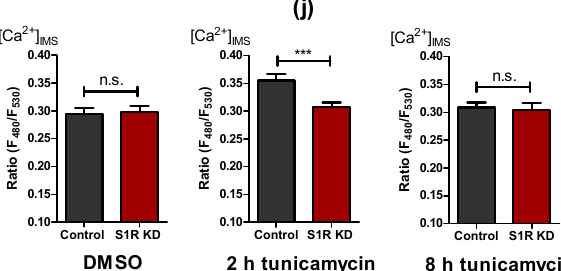
Figure 4. Cells develop an enhanced ER Ca 2+ leak that is directed towards mitochondria by S1R during early ER stress. Time course of ER Ca 2+ leak after tunicamycin treatment, presented as mean ± SEM and assessed by change in normalized D1ER ratio in control ( a ), S1R KD ( b ) and BD1047 treated ( c ) SH-SY5Y cells. Bar graphs represent MEAN ± SEM of ER Ca 2+ leak in control (black), S1R KD (red) and BD1047 treated (green) cells before tunicamycin treatment (left), after 2 h (middle), or 8 h (right) tunicamycin treatment ( d ). Time course of mitochondrial Ca 2+ level after tunicamycin treatment, presented as MEAN ± SEM and assessed by 4mtD3cpv ratio in control SH-SY5Y cells ( e ) and in cells with S1R KD ( f ). Bar graphs represent MEAN ± SEM of mitochondrial Ca 2+ levels in control (black) and S1R KD (red) cells before tunicamycin treatment (left), after 2 h (middle), or 8 h (right) tunicamycin treatment ( g ). Time course of IMS Ca 2+ level after tunicamycin treatment, presented as MEAN ± SEM and assessed by IMS-GEM-GECO ratio in control SH-SY5Y cells ( h ) and in cells with S1R KD ( i ). Bar graphs represent MEAN ± SEM of IMS Ca 2+ levels in control (black) and S1R KD (red) cells before tunicamycin treatment (left), after 2 h (middle), or 8 h (right) tunicamycin treatment ( j ). One-way ANOVA with Tukey’s multiple comparison test ( a – c , e , f , h , i ), ** * p < 0.001, * * p < 0.01, * p < 0.05, ## p < 0.01 (for h, control 2 h tunicamycin against control 8 h tunicamycin), n.s.—not significant; unpaired t-test ( d , g , j ), ** * p < 0.001, * * p < 0.01, * p < 0.05,